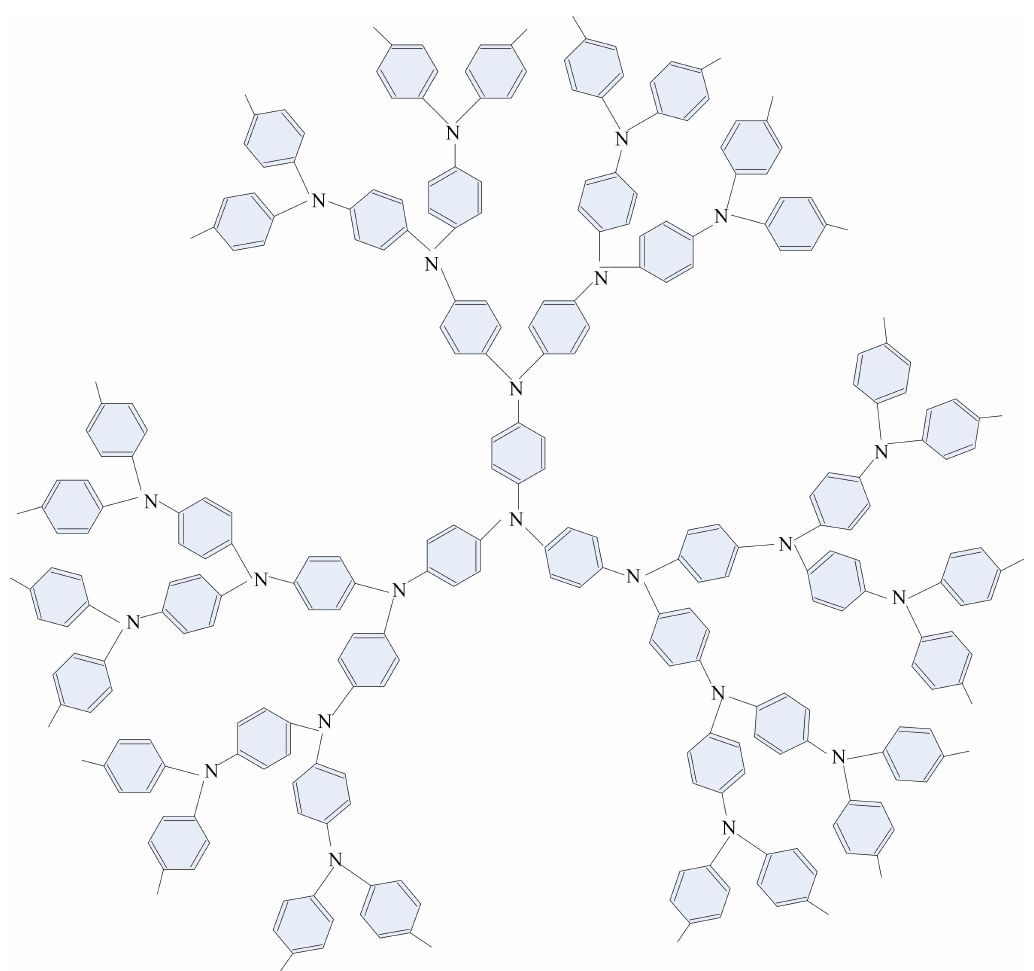
Fig. 9 The 2-Dimensional of the n -th growth of nanostar dendrimer D 3 [ n ]